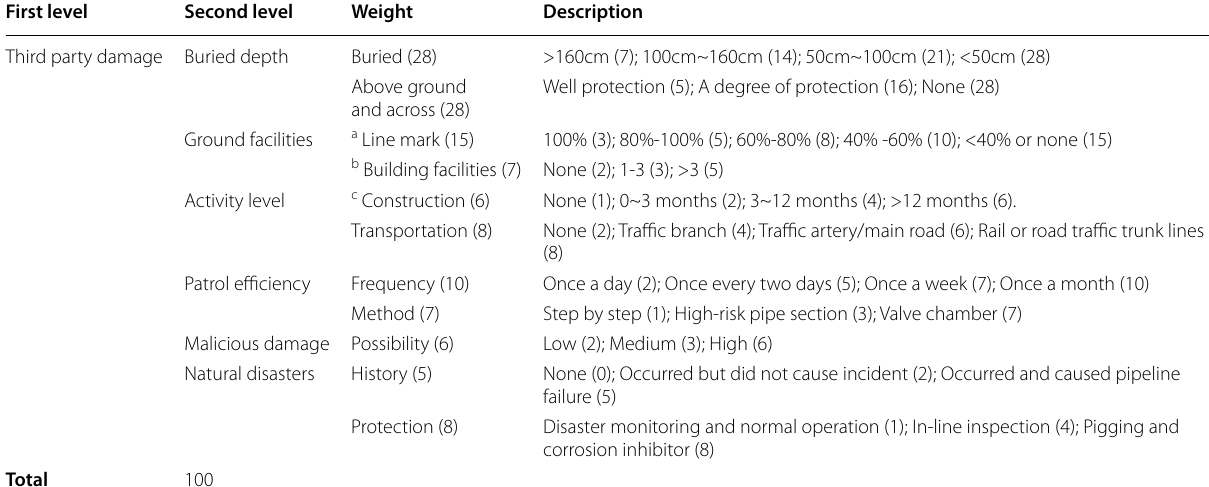
Table 2 Failure factors of gathering pipelines regarding third-party